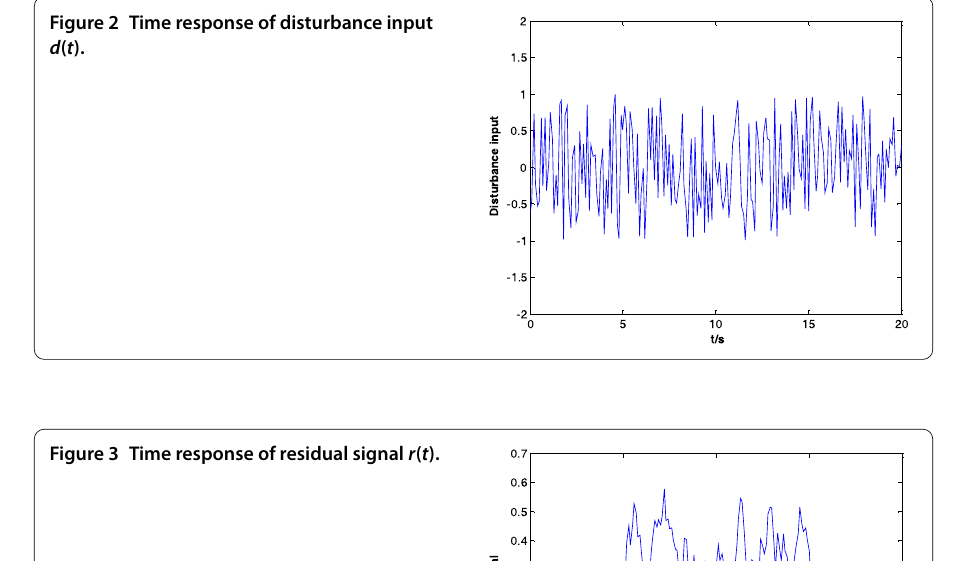
Figure 2 Time response of disturbance input d ( t ).